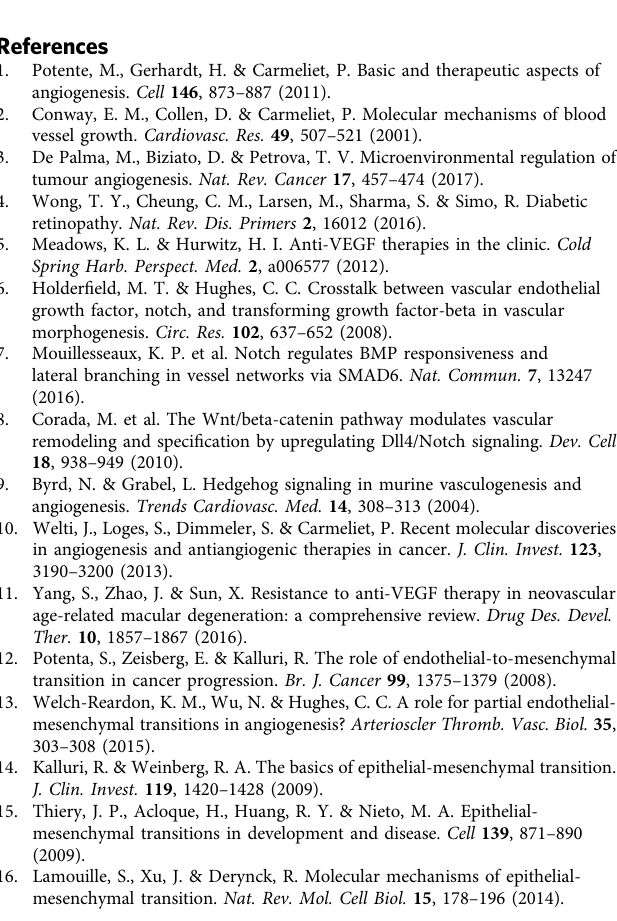
including immuno fl uorescence staining and western blot, were repeated with three or more experiments or biological replicates (cell lines, devices, and animals) unless otherwise noted. Q-PCR primer sequences for human and mouse genes . See Supplementary Table 1 (human) and Supplementary Table 2 (mouse). Reporting summary . Further information on research design is available in the Nature Research Reporting Summary linked to this article. Data availability All data generated or analyzed during this study are included in this published article (and its supplementary information fi les). The results of differential-gene-expression analysis results from the RNA-seq experiment are included in the Supplementary Data 1. Raw data are deposited into the GEO database under the accession code GSE154546. Source data are provided with this